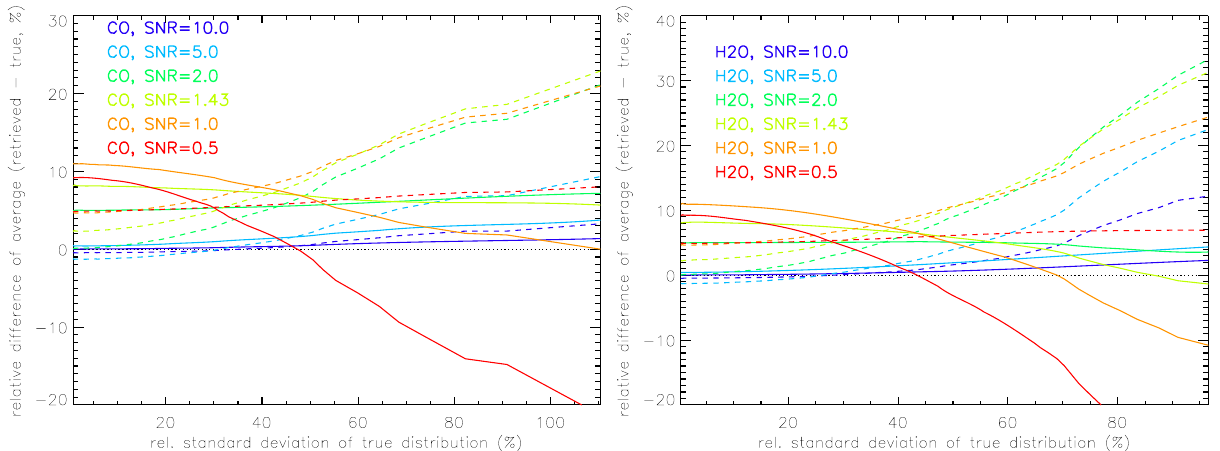
Fig. 8. Differences of retrieved and “true” zonal means (relative to the latter) versus local natural variability in terms of standard deviation for the CO (left) and H 2 O (right). Solid: linear averages, dashed: logarithmic averages. Simulations are performed with a modified maximum a posteriori ln(vmr)-retrieval simulations using a fixed constraint corresponding to climatological variance of 100%. Results for signal to noise ratios of 10 (dark blue), 5 (light blue), 2 (dark green), 1.43 (light green), 1.0 (orange), and 0.5 (red) are shown. The resulting a priori